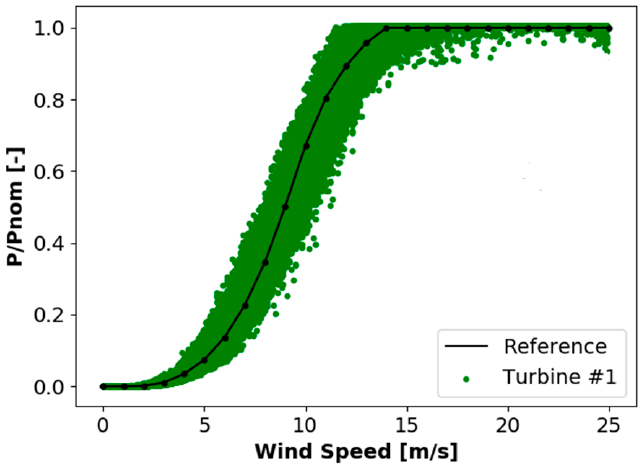
Figure 2. Reference power curve (data from [30] ) and data for turbine #1.